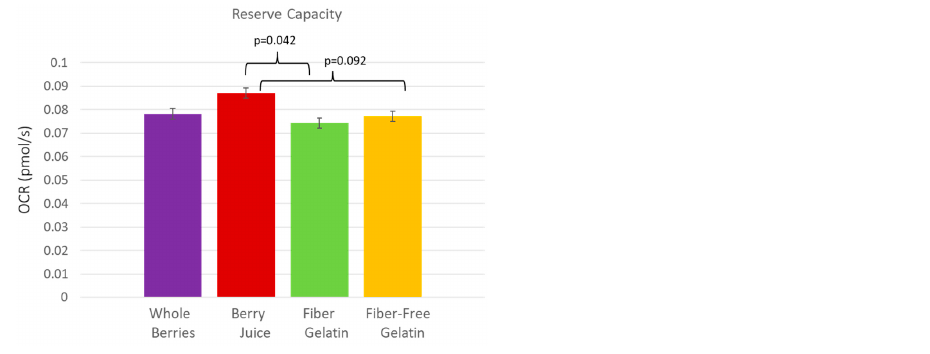
Figure 3. Reserve capacity in PBMCs after subjects consumed whole berries, berry juice, fiber- enriched gelatin, or fiber-free gelatin.